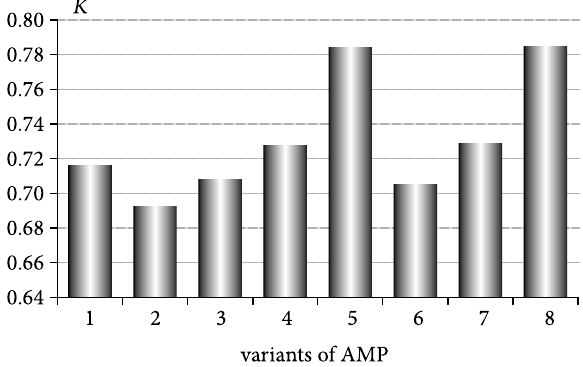
Fig. 2 . Graphical view of AMP‘s performance criterion K